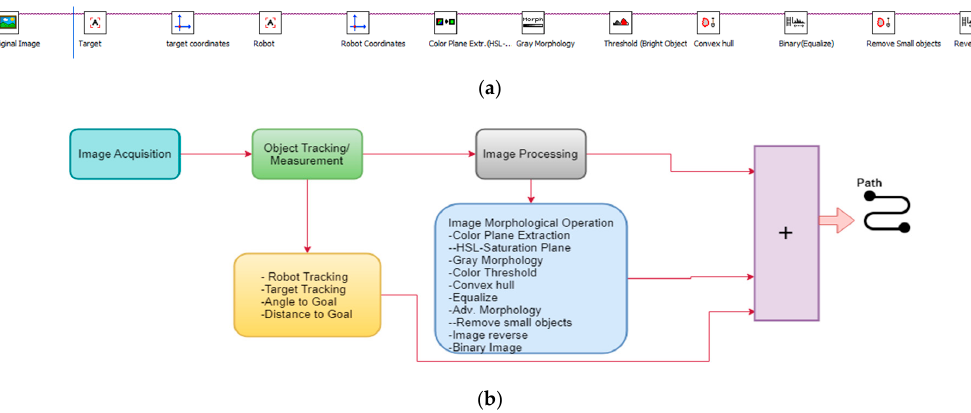
Figure 2. ( a ) Image analysis steps and ( b ) structure and functionality of the vision algorithm.